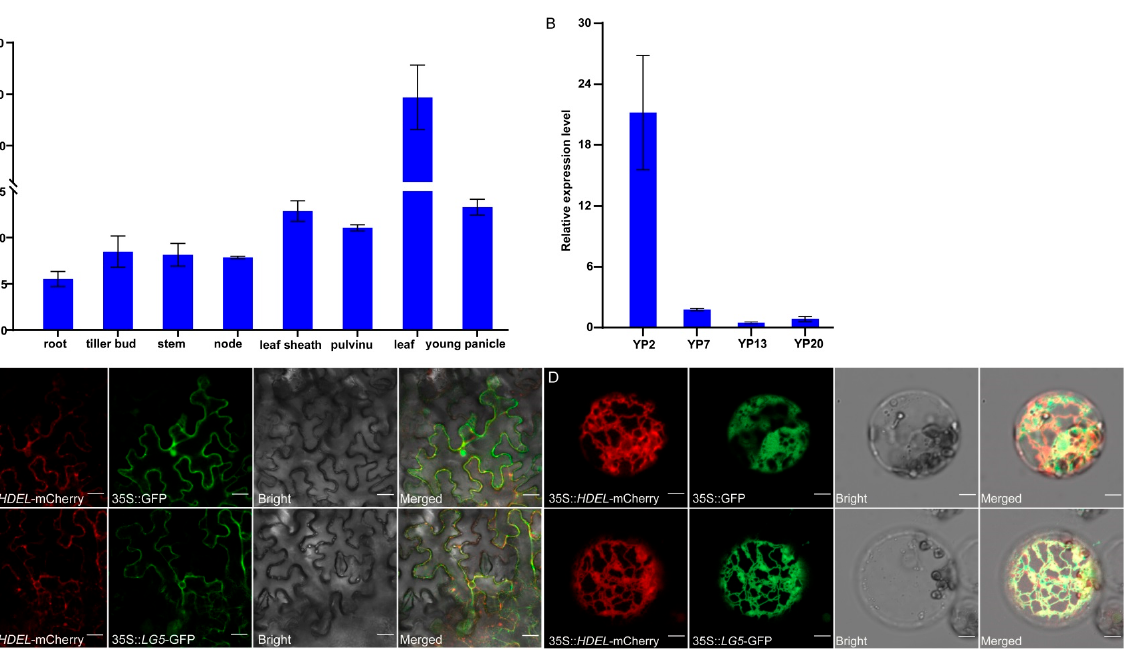
Figure 7. Expression pattern and subcellular localization of LG5 protein. ( A ) Relative expression levels in different tissues in XS. ( B ) Relative expression levels in young 2 cm (YP2), 7 cm (YP7), 13 cm (YP13), and 20 cm (YP20) panicles in XS. ( C ) Subcellular localizations in young tobacco leaf epidermal cells; bar = 20 μ m. ( D ) Subcellular localizations in rice protoplasts; bar = 5 μ m.